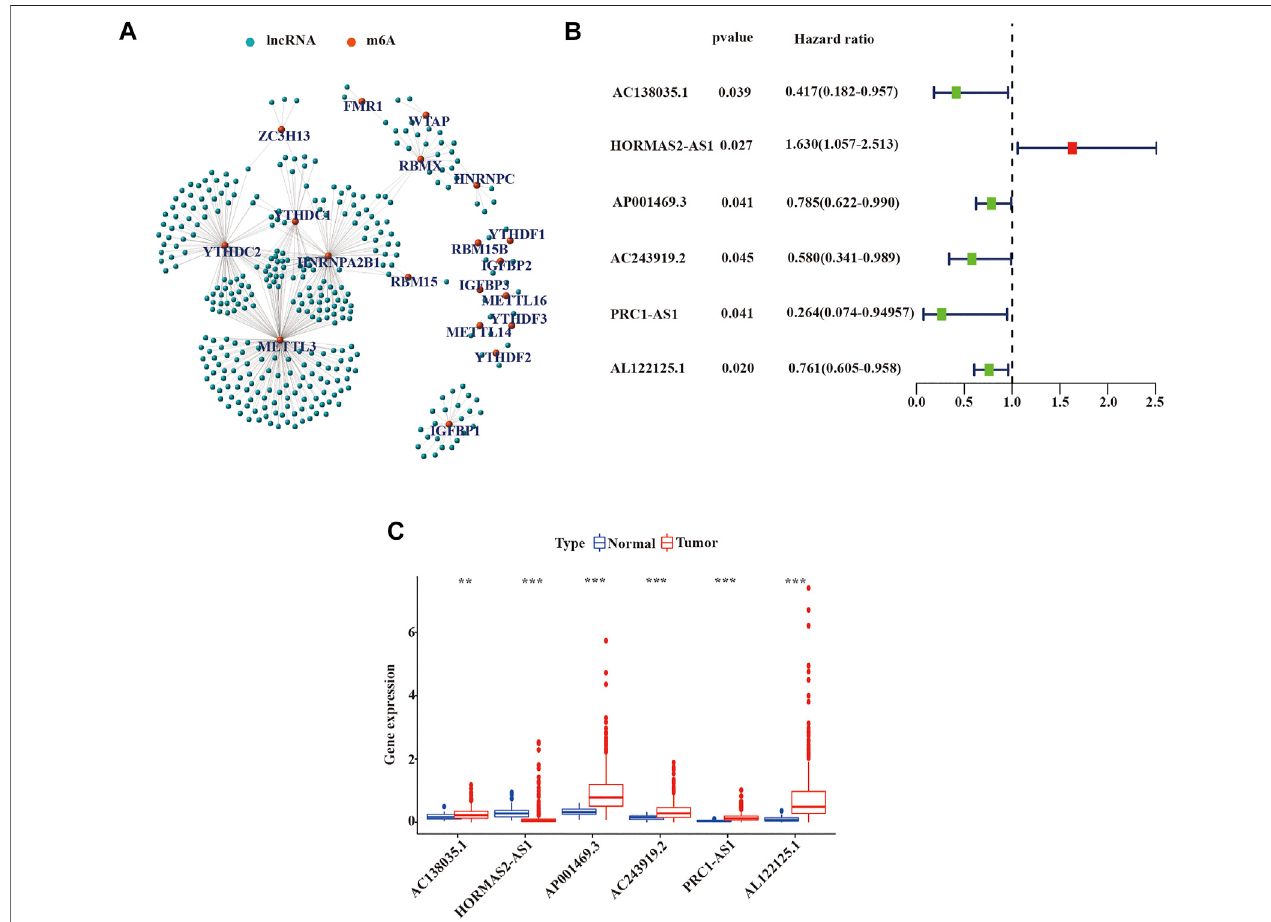
FIGURE 2 | Identi fi cation of m 6 A-related lncRNAs with prognostic value in LUSC patients. (A) Co-expression network of m 6 A-related genes and m 6 A-related lncRNAs. (B) m 6 A-associated lncRNAs with prognostic values were validated by univariate Cox analysis. (C) Expression of 6 prognostic m6A-related lncRNAs in tumor and normal tissues. LUSC, lung squamous cell carcinoma; m 6 A, N 6 -methyladenosine; lncRNAs, long non-coding RNAs; Statistical methods: Wilcoxon test ** p < 0.01 and *** p <